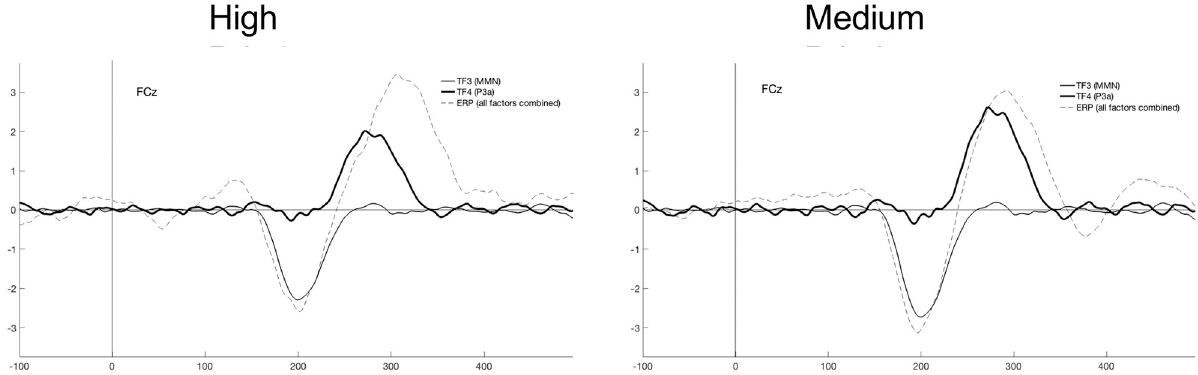
Fig 6. Plots of the Grand average of ERP (dashed line) versus Temporal Factor 3 and 4 of PCA identified as MMN (regular solid line) and P3a (bold solid line) respectively, for each priority at the location of the maximum peak